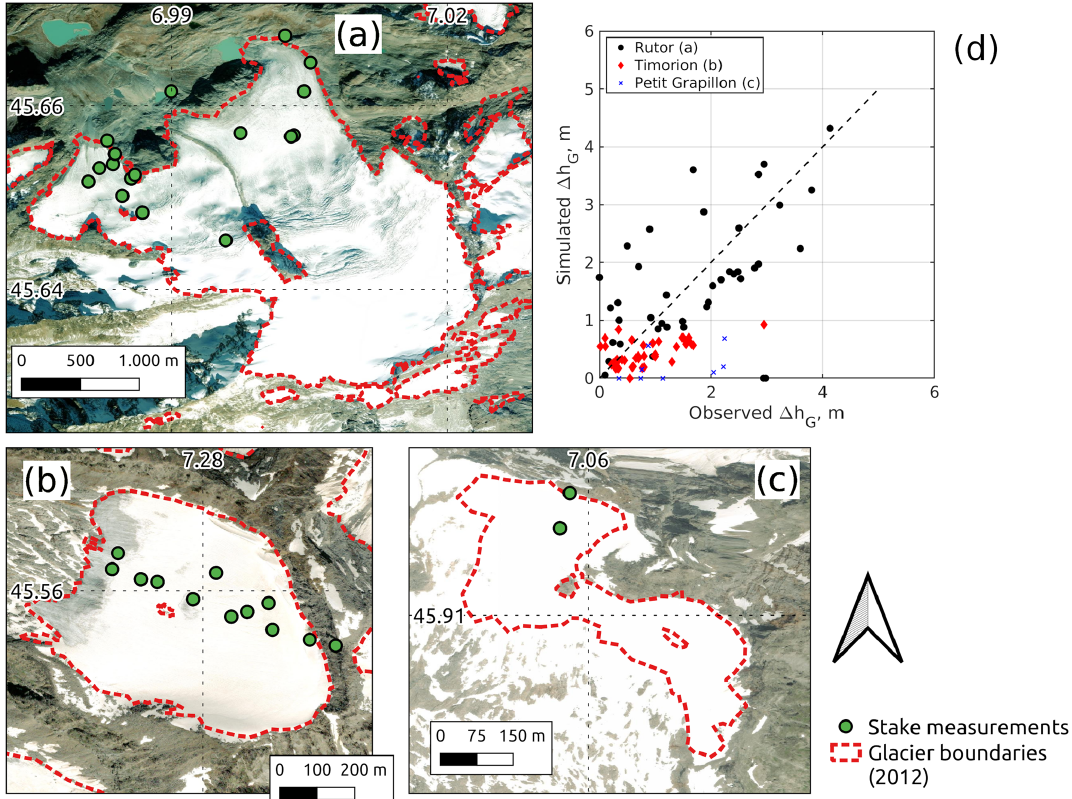
Figure 9. Spatial distribution of glacier-ablation measurements across the Rutor (a) , the Timorion (b) , and the Petit Grapillon (c) glaciers in the Aosta Valley. Panel (d) shows a comparison between measured and simulated ablation (positive values mean a decrease in local ice thickness). The number of points in panel (d) does not correspond to the number of stake locations in panels (a) to (c) because of repeated measurements taken across multiple water years as the same stake location. The background layer is from the ESRI Satellite